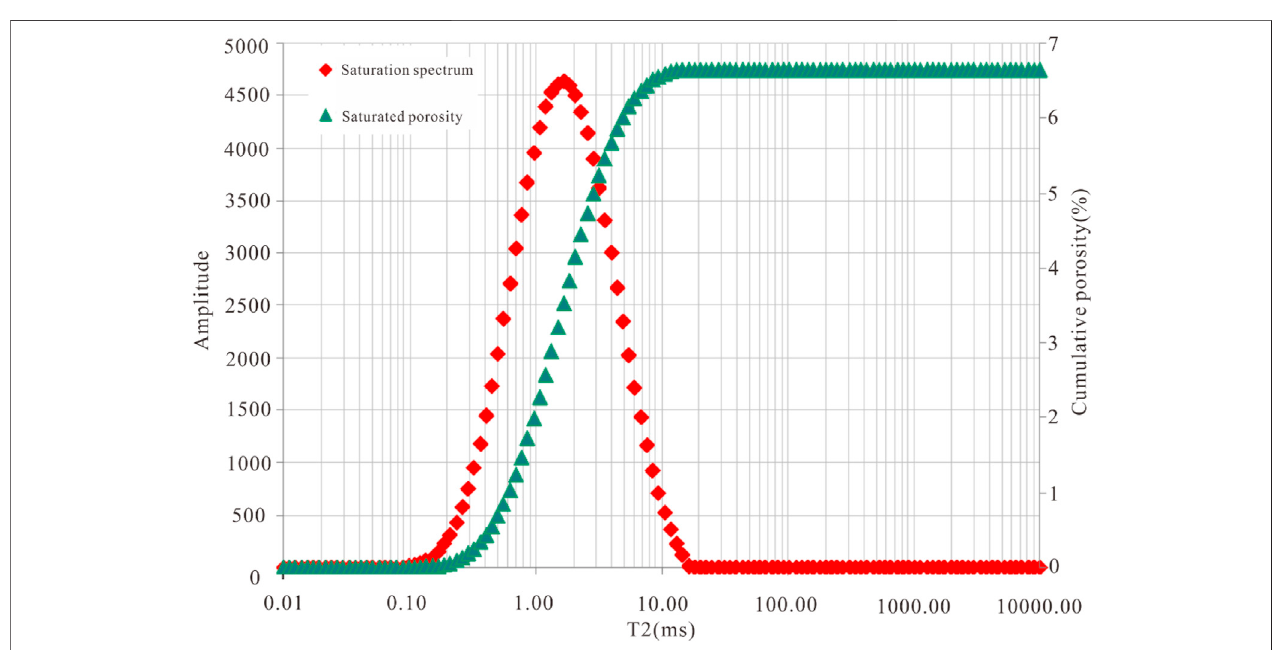
FIGURE 7 | NMR experimental results of core